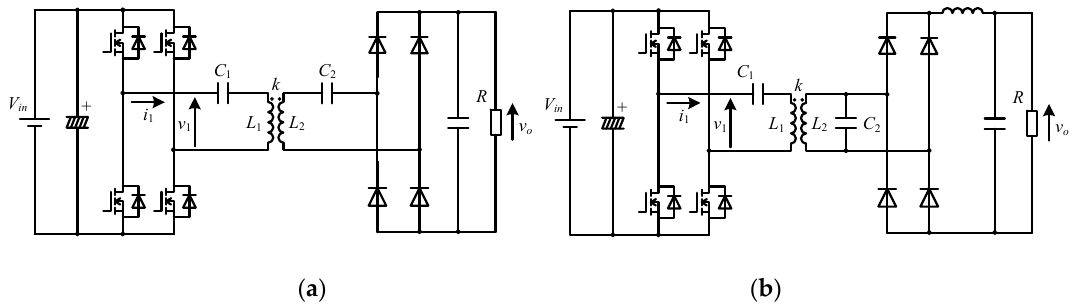
Figure 5. Circuit configuration of prototype: ( a ) is the series-series (SS) compensation method, and ( b ) is the series-parallel (SP) compensation method.